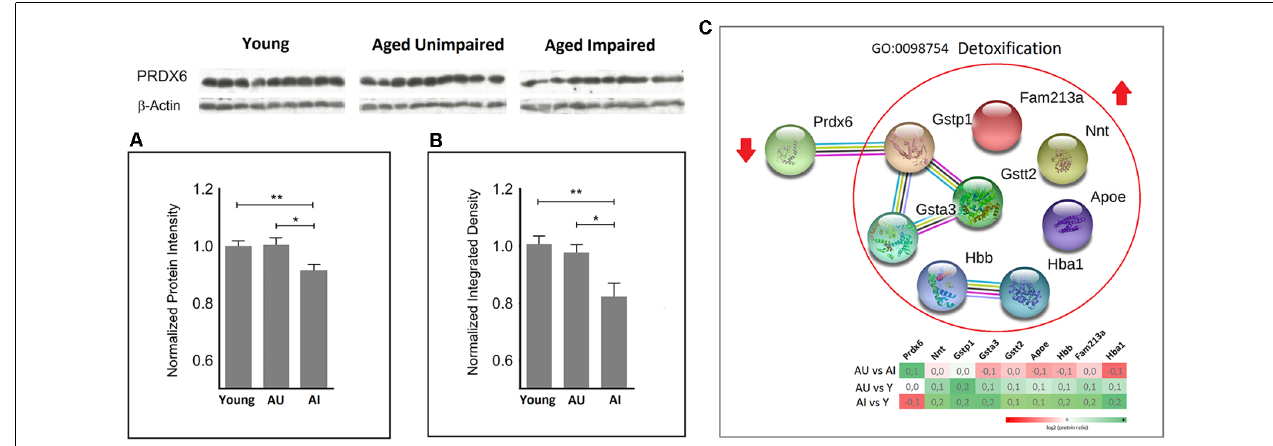
FIGURE 3 | Quantitative proteomic analysis (A) revealed significantly increased protein levels of peroxiredoxin 6 (PRDX6) in the AU vs. AI and young rats vs. AI (two-sided t -test). This finding was subsequently confirmed by immunoblot analysis (B) . A normalized protein ratio is represented by group means of normalized protein intensities vs. young control and is expressed as mean ratio ± SEM ( ∗ p -value < 0.05; ∗∗ p -value < 0.01; n = 9). (C) Representative GO term/cluster highlighted in enrichment analysis. Associated proteins are presented as association network using STRING 11. PRDX6 was the only protein in this cluster with decreased protein levels in AI compared to young and AU